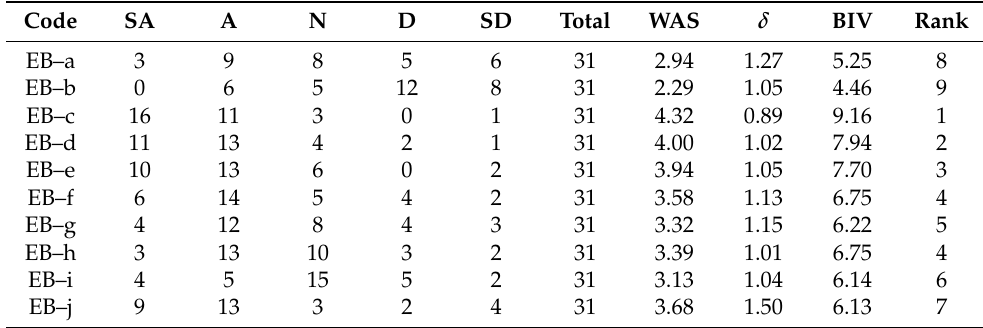
Table 6. Survey responses and calculation of parameter values to barrier factors.